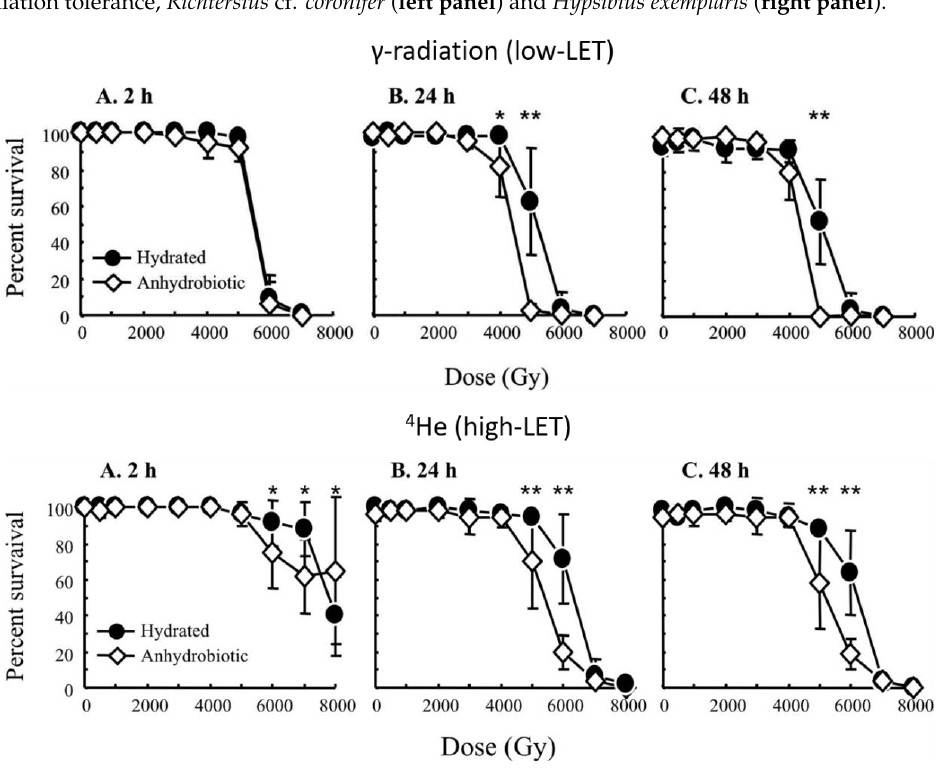
Figure 2. Dose-responses of the eutardigrade Milnesium tardigradum to exposure of γ -radiation (low-LET, upper panel) and helium ions (4He, high-LET, lower panel). Survival estimates after irradiation of both hydrated and desiccated (anhydrobiotic) animals are shown, and for estimates at 2, 24, and 48 h postirradiation (hydrated animals) or postrehydration (desiccated animals). Reprinted from Horikawa et al. [27] (Figures 1 and 2) by permission of the publisher (Taylor & Francis Ltd.). Asterisks represent significant differences in survival between the hydrated and anhydrobiotic groups at p < 0.05 (*) and p < 0.001 (**) levels.